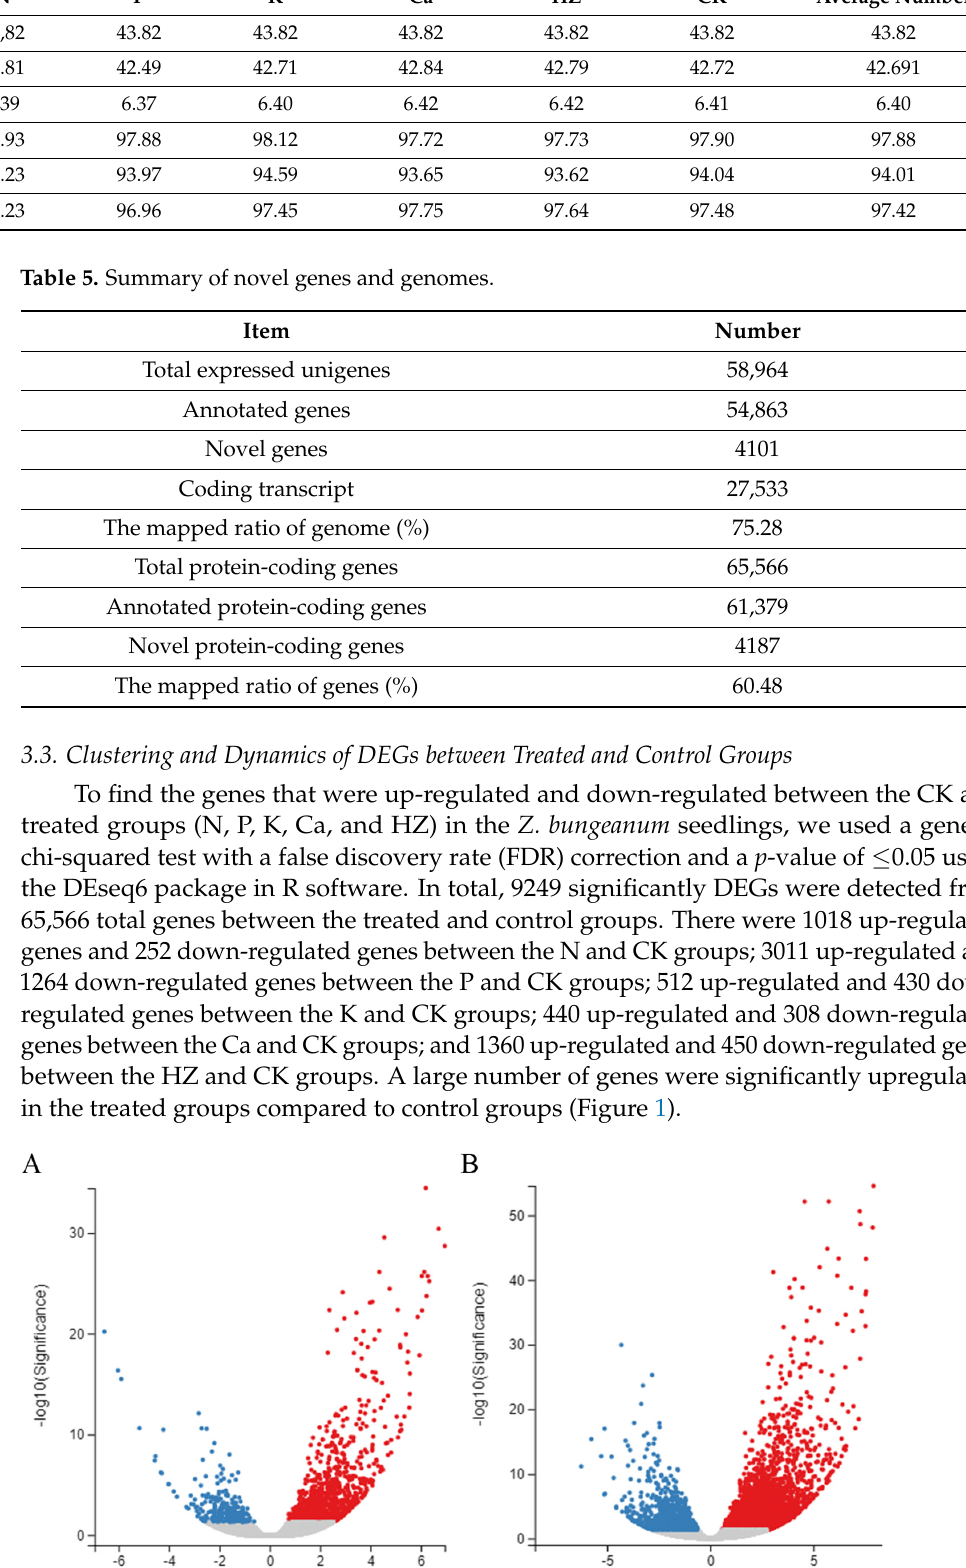
Figure 1. The volcano plots of differentially expressed genes (DEGs) between the N- ( A ), P- ( B ), K- ( C ), Ca- ( D ), and HZ- ( E ) treated and CK (control group) groups in Z. bungeanum seedlings. Significantly up-regulated unigenes are shown by red plots, whereas significantly down-regulated unigenes are represented by blue plots ( p ≤ 0.05). There is no substantial differential expression in the grey plots.